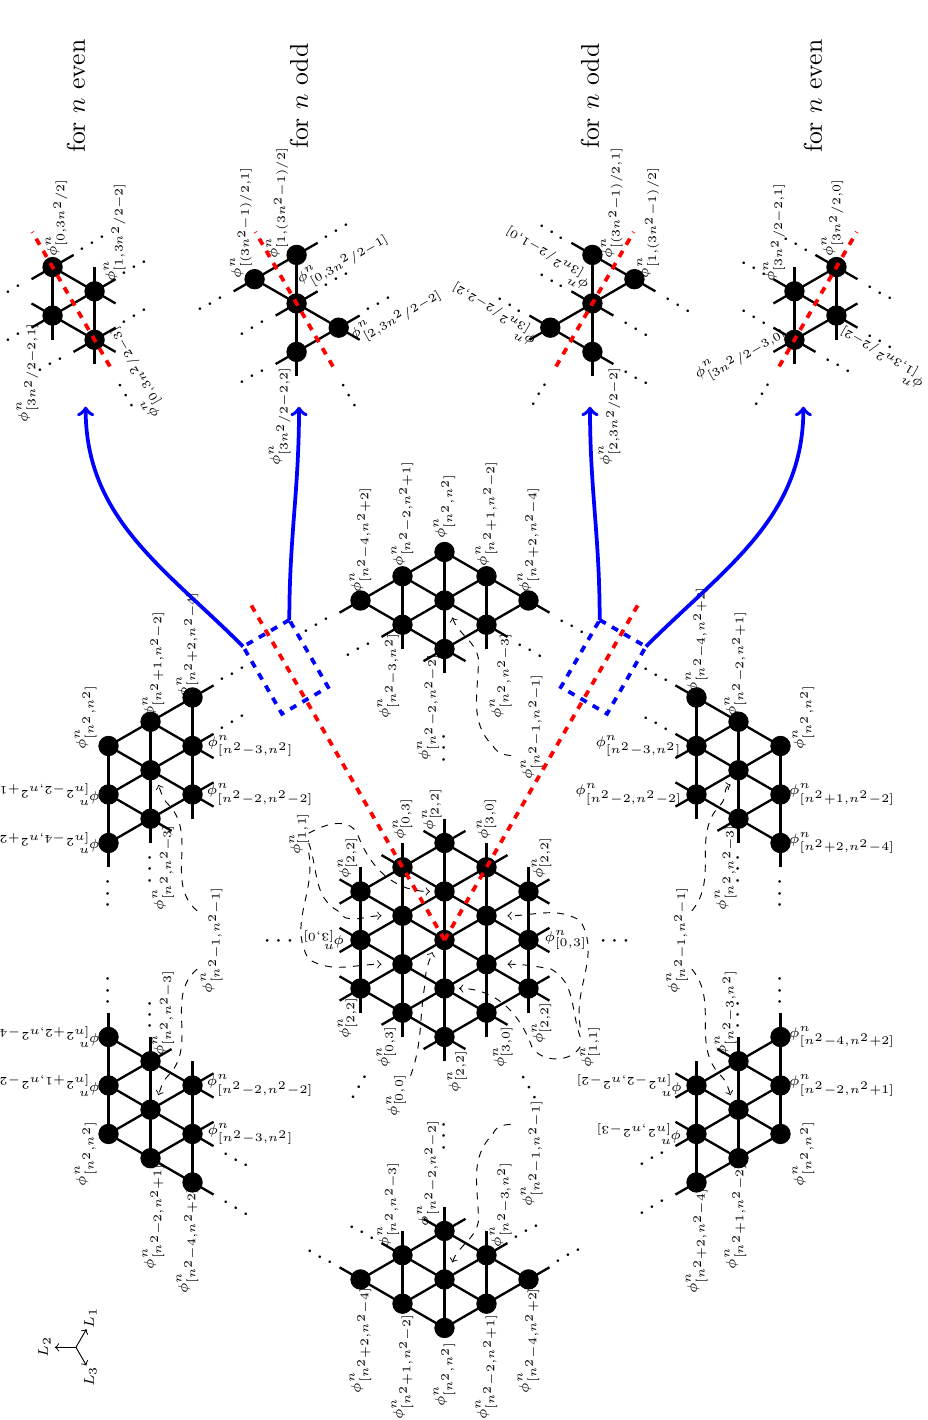
Figure 2 . Representation of Z line